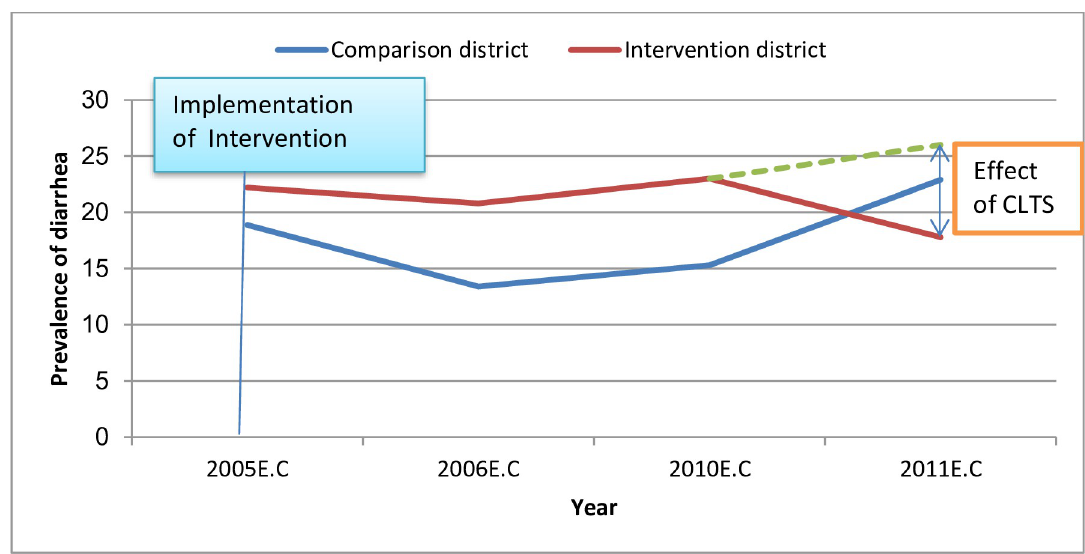
Fig 3. Difference-in-Difference on prevalence of diarrhea in children less than five years in intervention and comparison districts, Jimma zone, Oromia region, southwest Ethiopia,